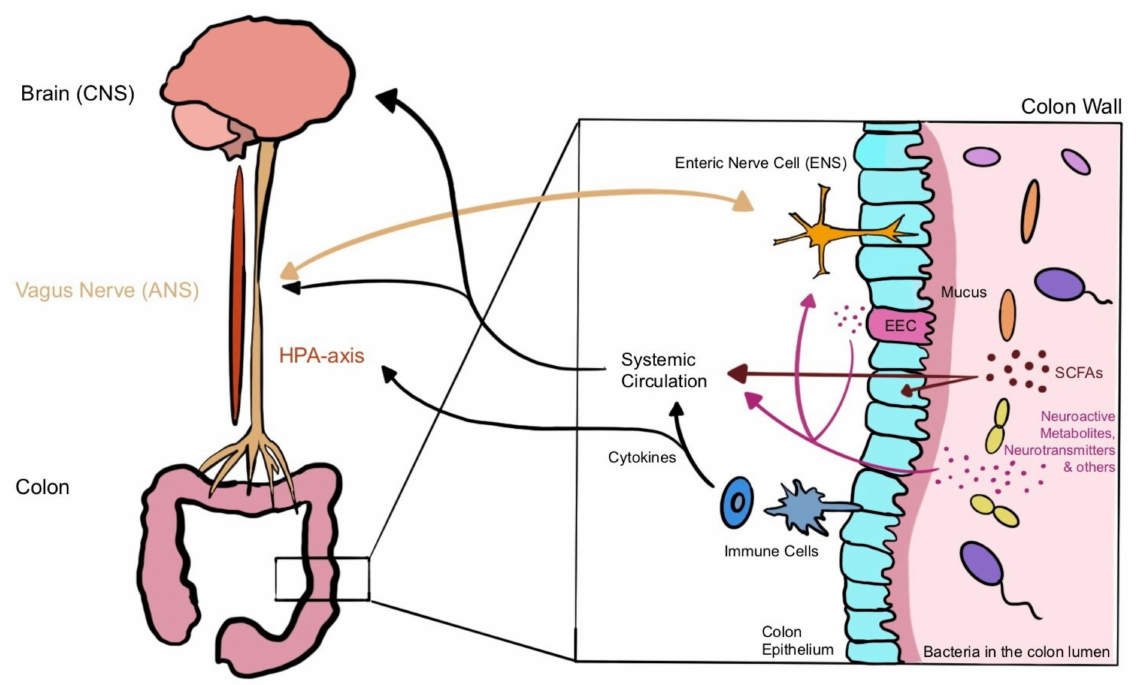
Figure 1. Schematic overview of the bidirectional communication pathways between the gut- microbiota and the brain (Microbiome–Gut–Brain Axis (MGBA)). The colon is inhabited by many different bacteria strains, which directly or indirectly interact with the nerve cells and the